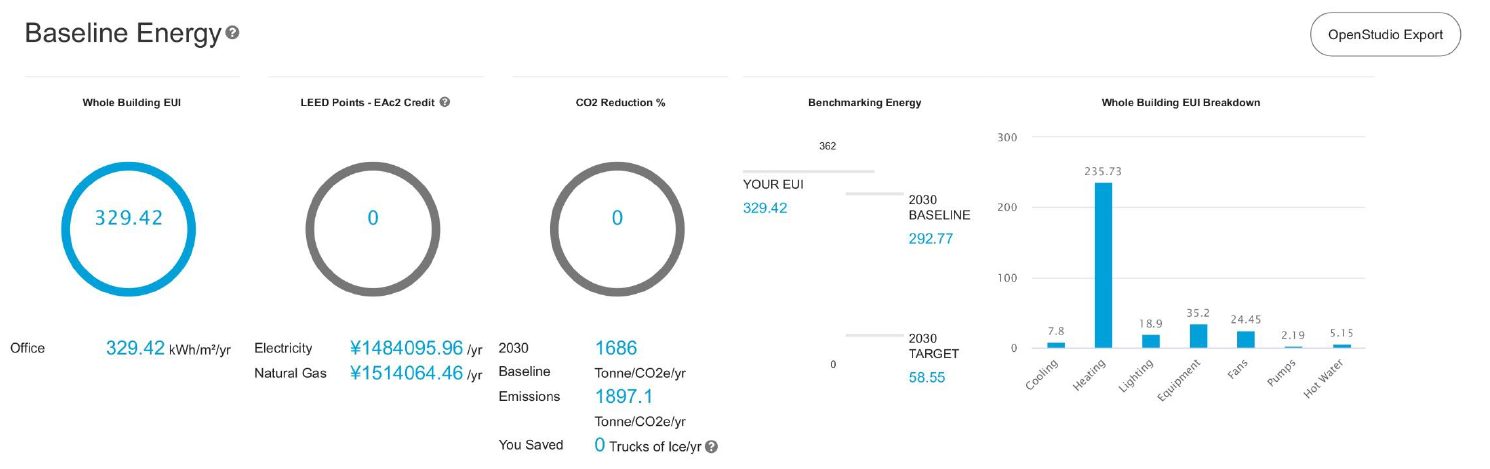
Figure A16. Zone 4-B Beijing, Beijing (pre-COVID-19 scenario).